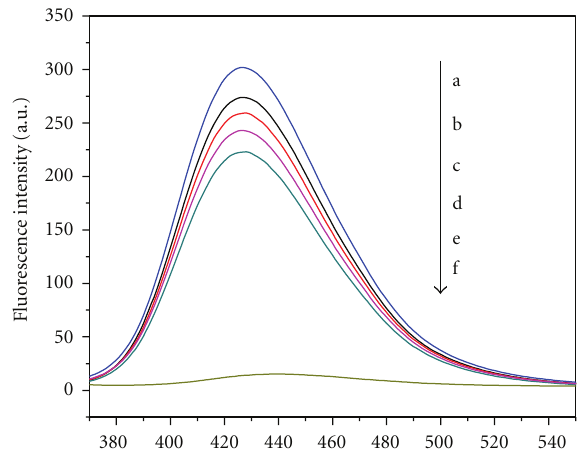
Figure 9: E ff ect of ball milling time on the changes of PL spectra. (a) 6 h, (b) 3 h, (c) 12h, (d) 24h, (e) 1 h, (f) pure terephthalic acid.